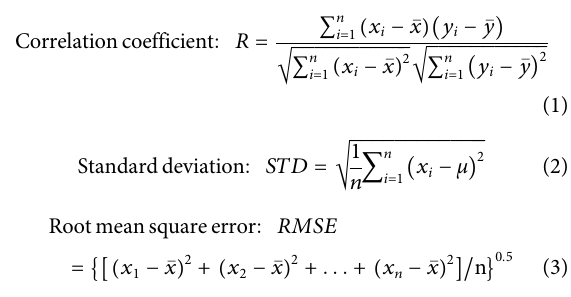
Where R corresponds to correlation coef fi cient; x is the dataset of the test fi eld; y is the dataset of the observed fi eld; x i and y i indicate data size of the i th sample in the dataset of the test fi eld and the observed fi eld, respectively; (cid:2) x and (cid:2) y correspond to the means of the dataset of the test fi eld and the observed fi eld, respectively; n is the sample size; μ is the mean of the dataset; STD indicates standard deviation; and the standard deviation ratio is represented by STDR (cid:1) STD T STD , the ratio of the standard deviation O of the test fi eld ( STD T ) to that of the observed fi eld ( STDo ).